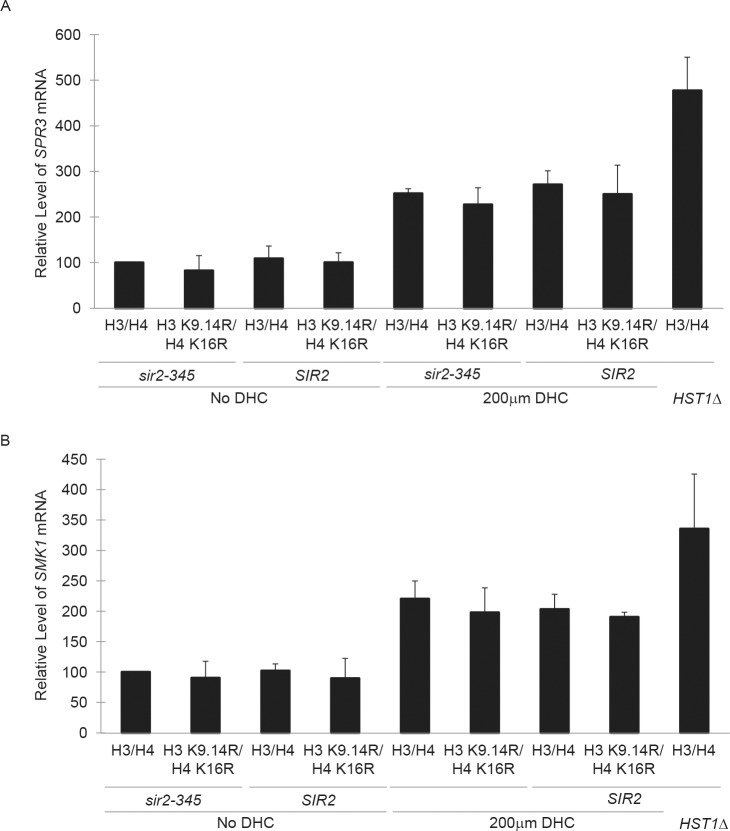
DHC disrupts Hst1p-dependent repression of midsporulation genes.Transcript levels of SMK1 (a) or SPR3 (b) relative to SCR1 were determined by qRT-PCR for SIR2 or sir2-345 strains expressing wild-type or hypoacetylated H3/H4 mutants in the presence or absence of DHC, and compared to sir2-345 expressing wild-type H3/H4 in the absence of DHC, which was set to 100%. Data was calculated as: 2[(LocusCT − SCR1CT)SIR2 − (LocusCT − SCR1CT)sir2-345 H3/H4] (AVG ± SD, n = 3).